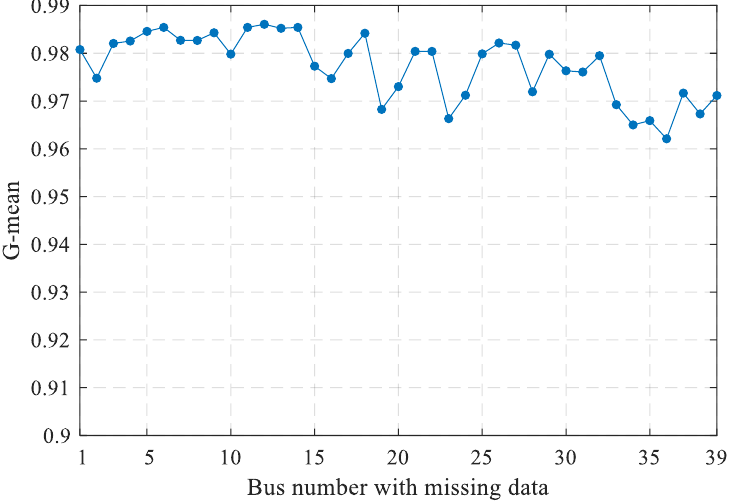
Figure 12. G-mean metric results for missing PMU data.